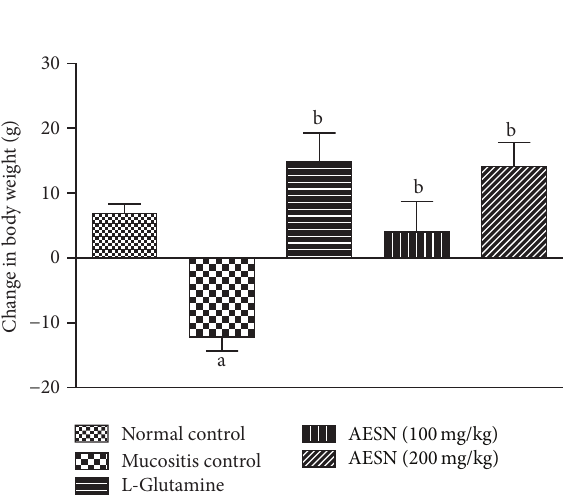
Figure8:Averagefoodintakeinmethotrexateinducedoralmucosi- tis. 15 g of food was provided for each animal of five groups till the end of study period. All values are expressed as mean ± SEM of 6 animals. a 𝑃 < 0.05 versus normal control, b 𝑃 < 0.05 versus mucositis